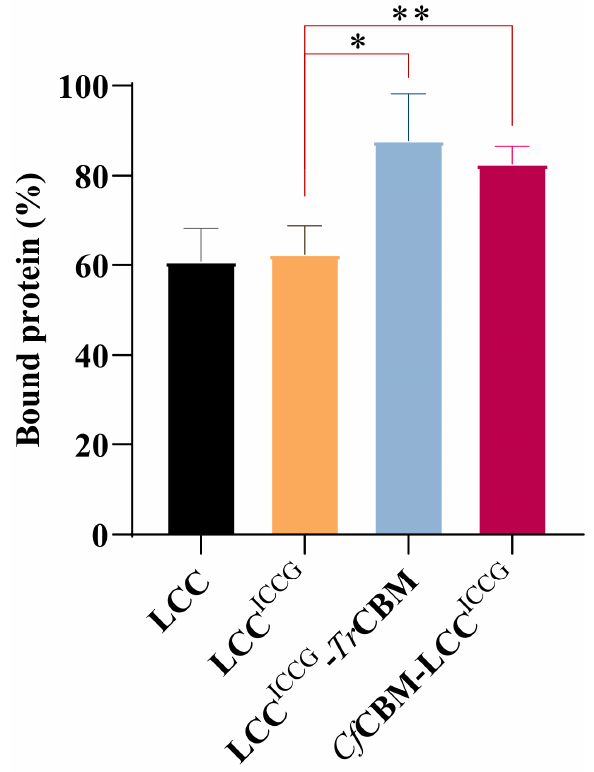
Figure 5. Binding ability analysis of LCC, LCC ICCG , LCC ICCG - Tr CBM and Cf CBM-LCC ICCG on PET films. In the experiment, 50 nM of fusion proteins was mixed with 200 µ L of potassium phosphate buffer (100 mM, pH 8.0) containing 3 mg of PET films, and the supernatant was collected through centrifugation after the treatment at 4 ◦ C for 24 h. Data were presented as mean value ± SD of triplicate experiments, * p < 0.05 and ** p < 0.01.